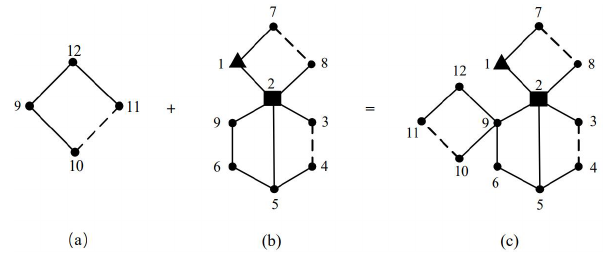
Figure 4. (a) Auxiliary arm topology, (b) main boom topology and (c) mechanism